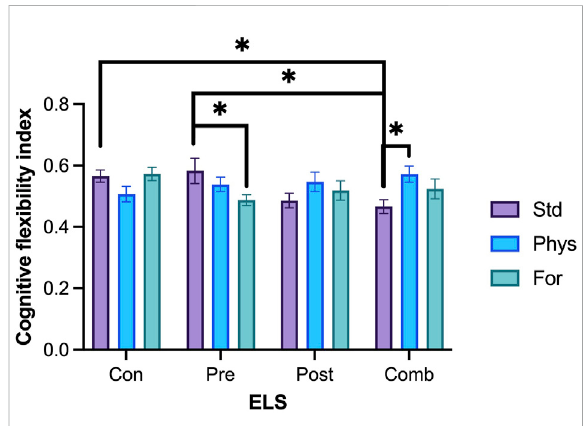
FIGURE 8 Cognitive fl exibility index. Rats exposed to prenatal ELS with Foraging-EE (n = 18) displayed a lower cognitive fl exibility index compared to the ones exposed to the same prenatal ELS with standardhousing(n=18).RatsexposedtocombinedELSand housed with Physical-EE (n = 16) showed a higher cognitive fl exibility index compared to the ones exposed to the same ELS with standard housing (n = 19). Rats exposed to prenatal ELS with standard housing (n = 18) displayed a higher cognitive fl exibility index compared to the ones exposed to combined ELS with standard housing (n = 19). Rats exposed to combined ELS with a standardhousing(n=19)showedalowercognitive fl exibilityindex compared to the ones with no ELS with standard housing (n = 19). Abbreviations: ELS, Early life stress; Con, Control; Pre, Prenatal; Post, Postnatal; Comb, Combined; EE: Std, Standard; Phys, Physical-EE; For, Foraging-EE; Comb, Combined. Three Way ANOVA (see Table 1 for statistical results): * p <